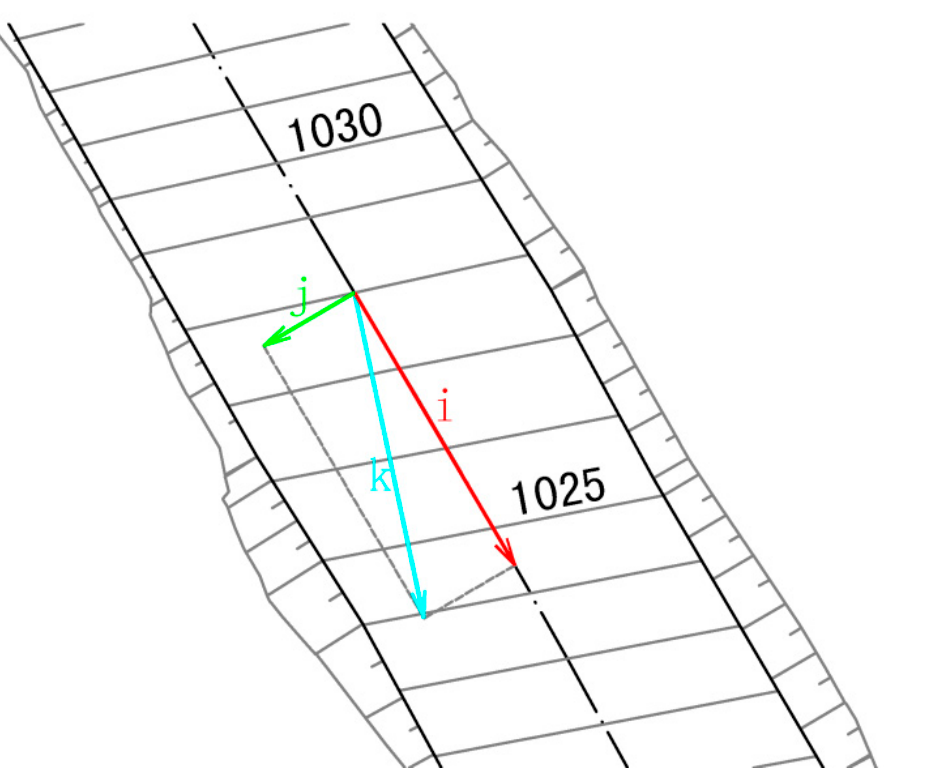
Figure 10. The contour lines of the ski track with cross slope.